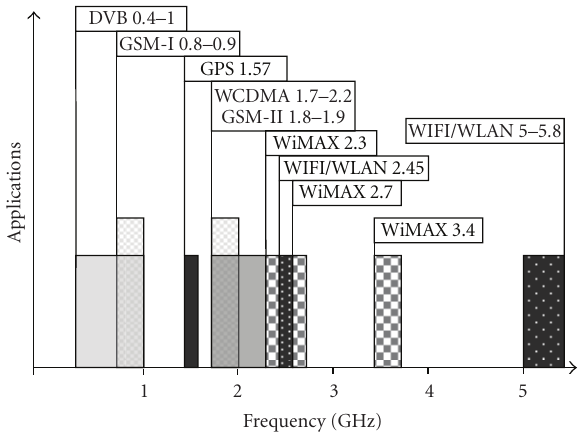
Figure 2: Frequency bands covered with composite antennas.